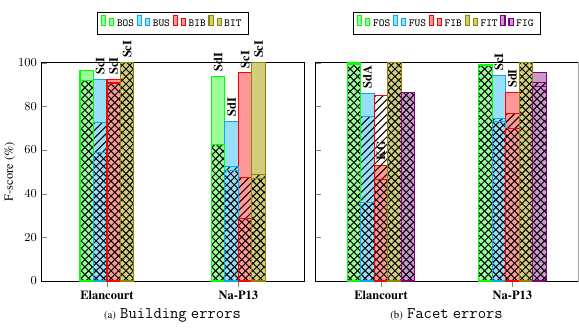
Figure 8. Transferability experiment F-scores obtained with an RF or an SVM using ScatNet features (in color). Hash bars: north east lines for Vanilla F-scores (Figure 6) and north west lines for the Vanilla baseline